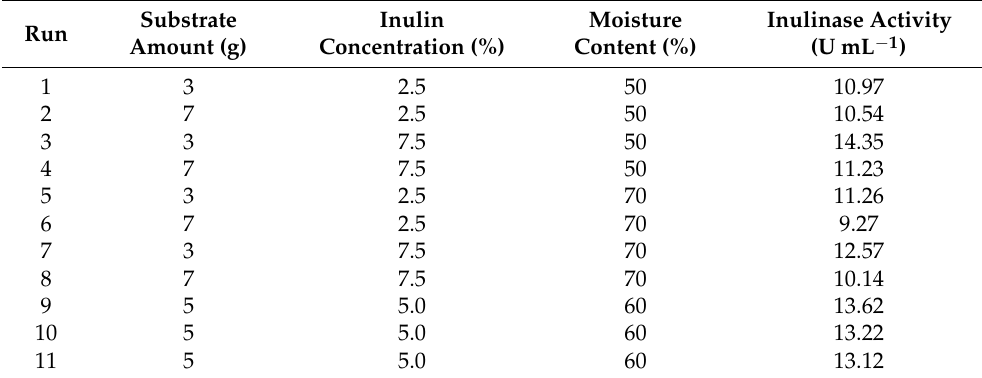
Table 3. Experimental conditions and results of inulinase production by Aspergillus terreus URM4658 in solid-state fermentation carried out at 30 ◦ C for 72 h using wheat bran as a substrate. Runs were carried out according to a 2 3 -full factorial